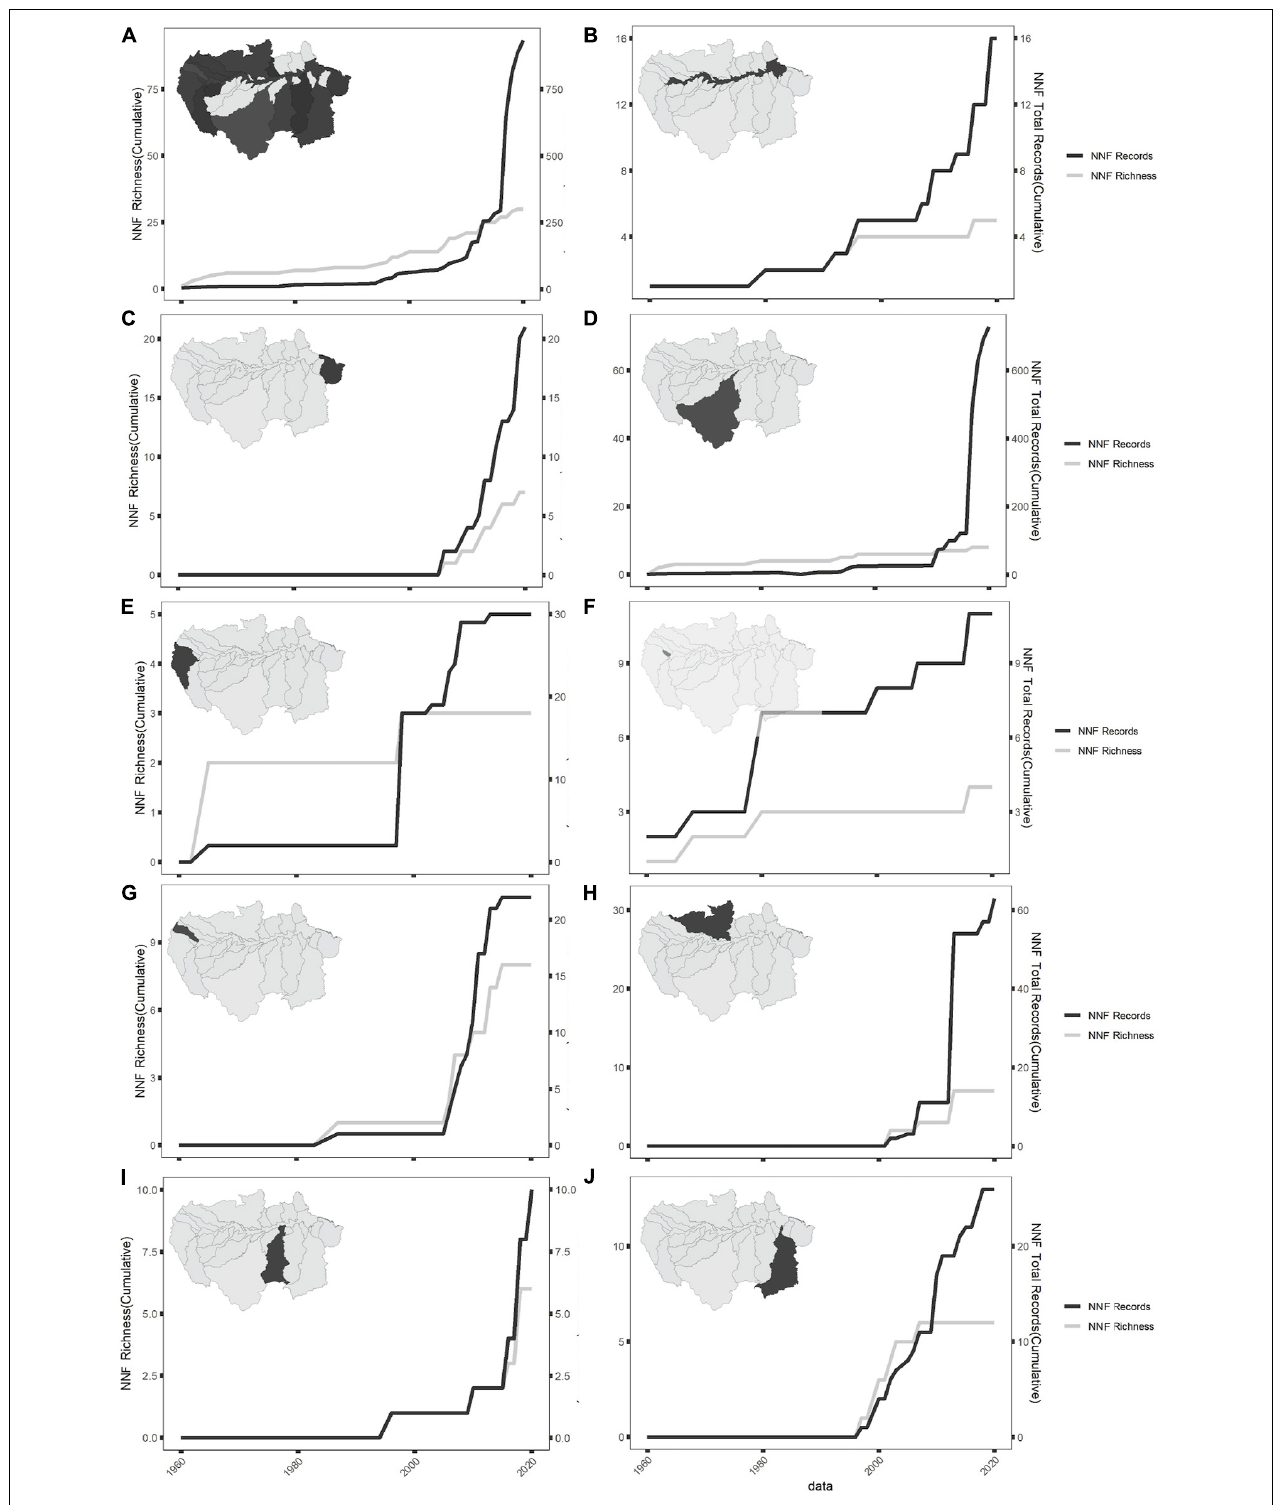
FIGURE 3 | Cumulative curve of NNF records (black lines) and first occurrence record (gray lines), NNF richness in the Amazon region, considering the river subbasins and adjacent basins. Please note that Y -axis are not at the same scale to avoid hindering exponential visual trends due to scaling effects of the data. Legend: A —Amazon region; B —Amazon River; C —Amazon Estuary; D —Madeira River; E —Maranon River; F —Nanay River; G —Napo River; H —Negro River; I —Tapajós River; J —Tocantins River (Venticinque et al., 2016).